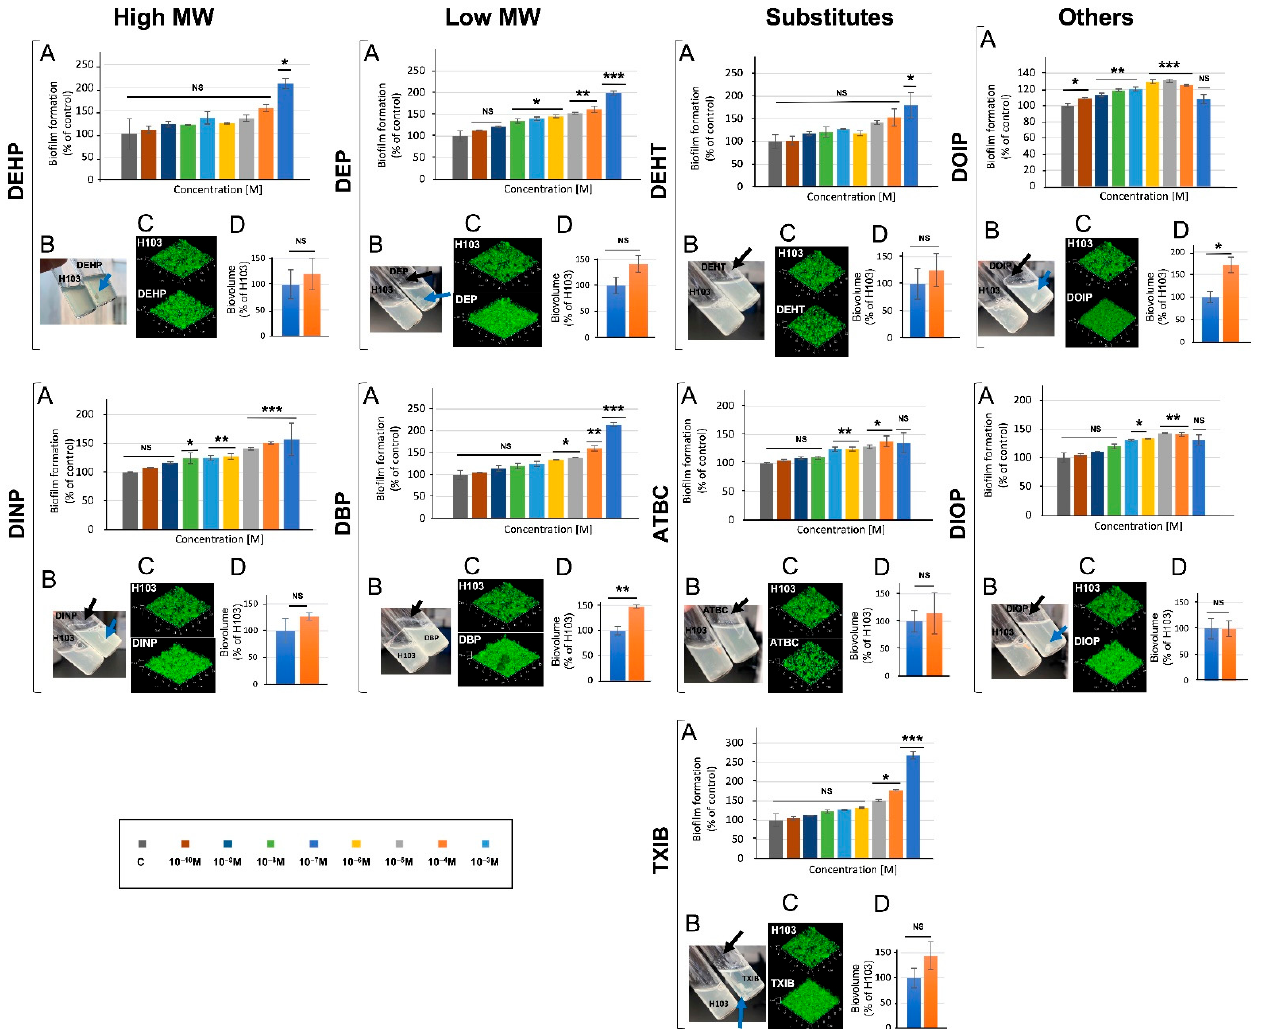
Figure 5. Phthalates and substitutes affect biofilm formation . Biofilms were investigated in poly- styrene plates ( A ), at the air–liquid interface ( B ), by confocal laser scanning microscope observation ( C ), and by COMSTAT analysis of their biovolumes ( D ). NS = p > 0.05; * = p < 0.05; ** = p < 0.01 *** = p < 0.001.